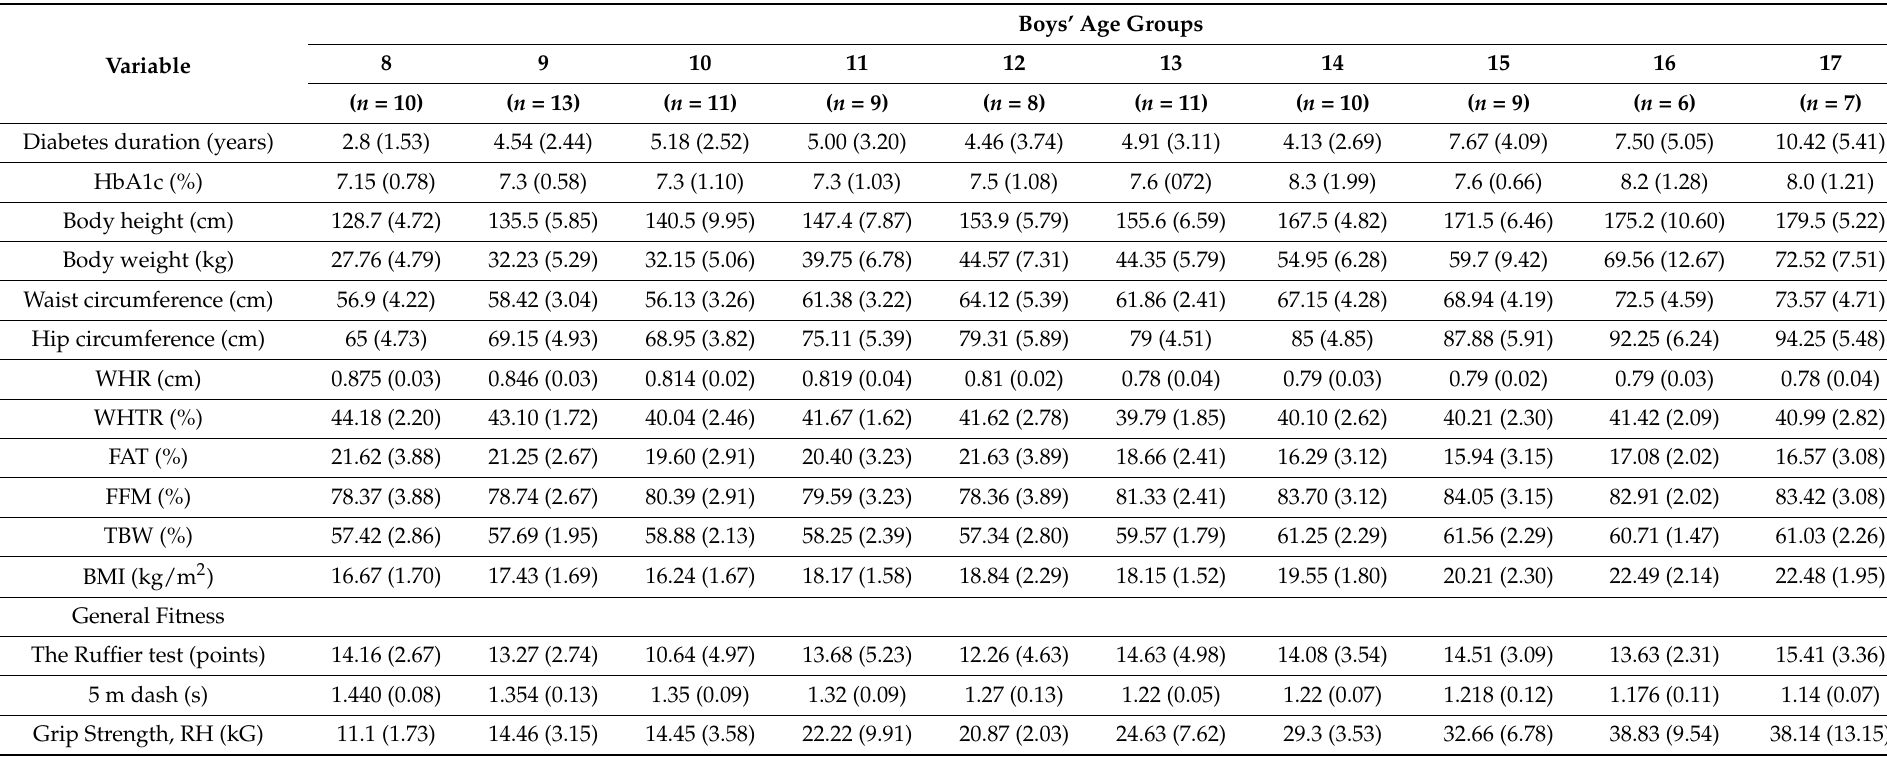
Table 1. Main characteristics of children with type 1 diabetes in all age categories (M ±